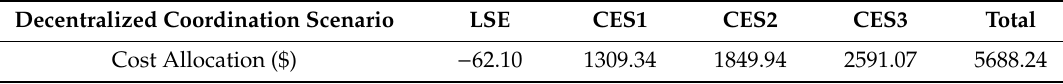
Table 4. The cost allocation scheme based on